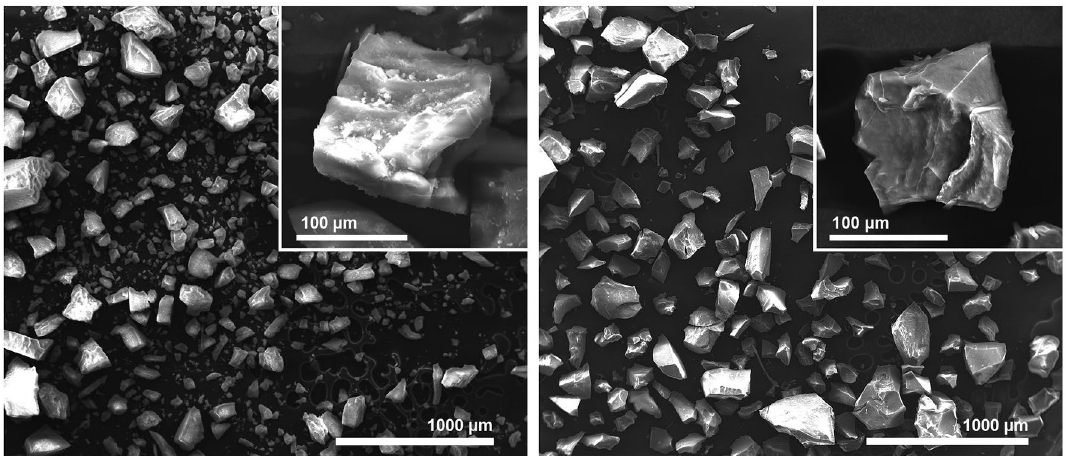
Figure 1. Environmental scanning electron microscopy images of Si-rich (Al:Si 1.4, left) and Al-rich short- range ordered aluminosilicates (Al:Si 2.6, right). The images were taken by Christian Buchmann.